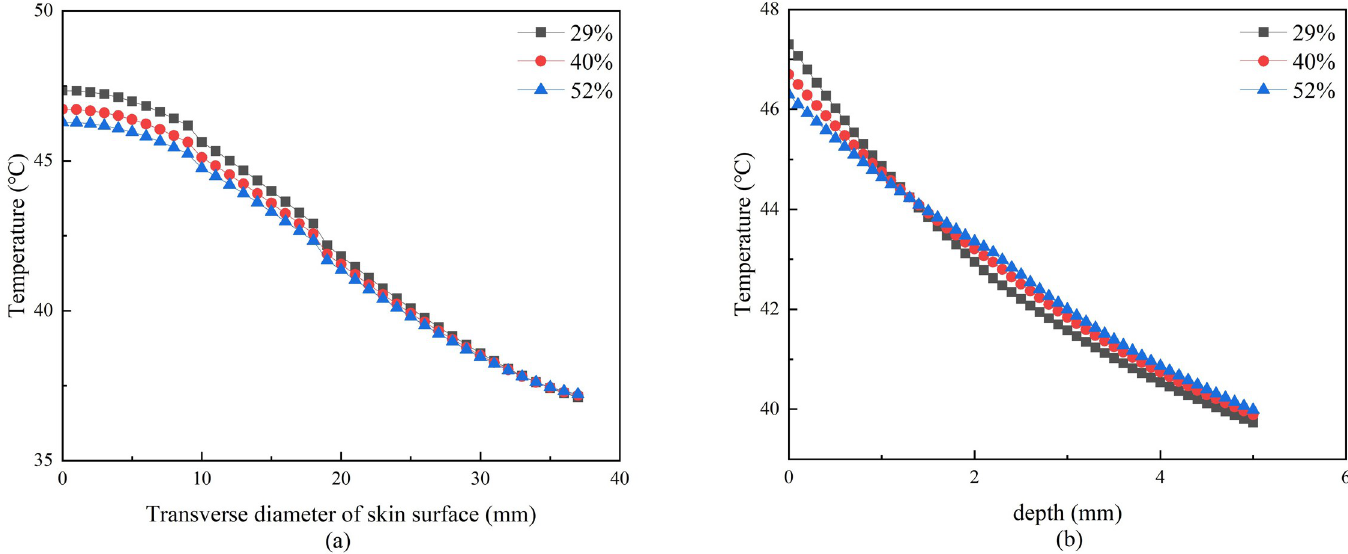
Fig 12. (a) Lateral temperature curve of skin surface with different skin moisture content. (b) Vertical skin temperature curve with different skin moisture content.